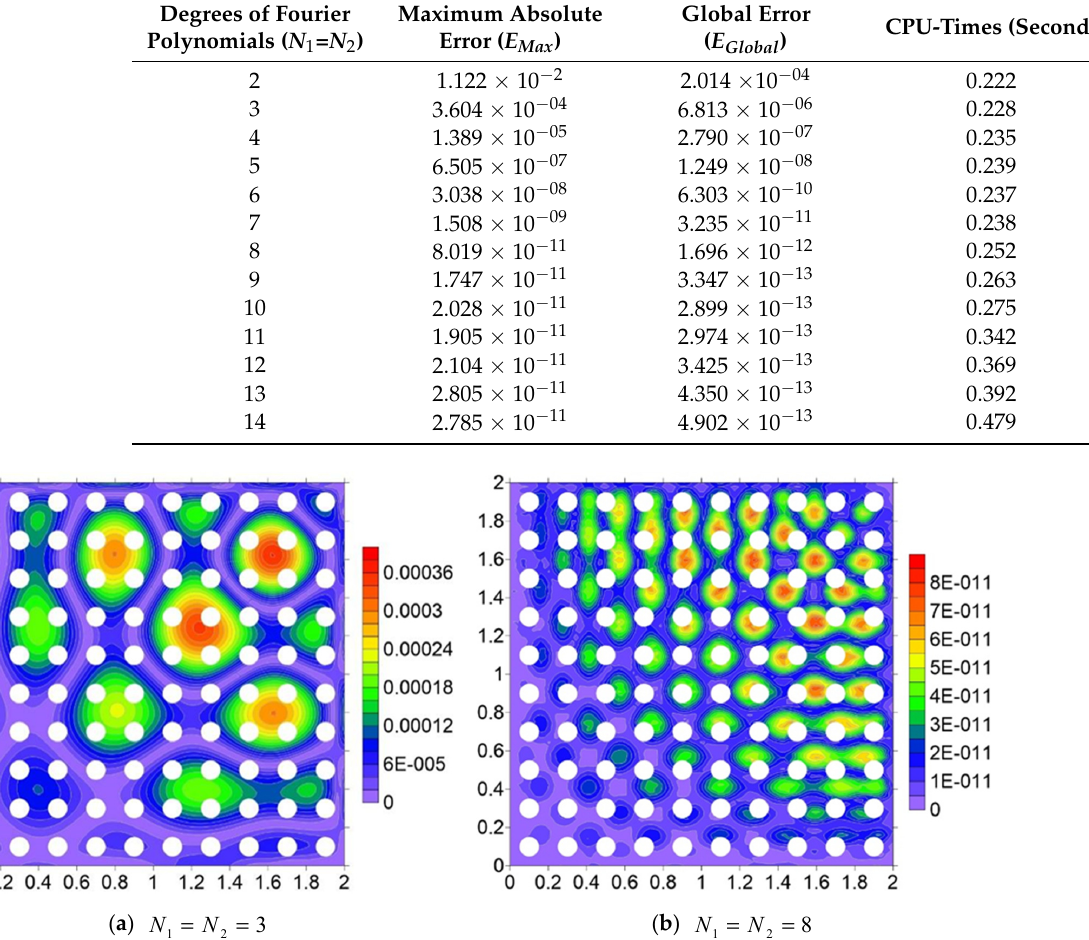
Table 2. Numerical results with respect to various degrees of Fourier polynomials.